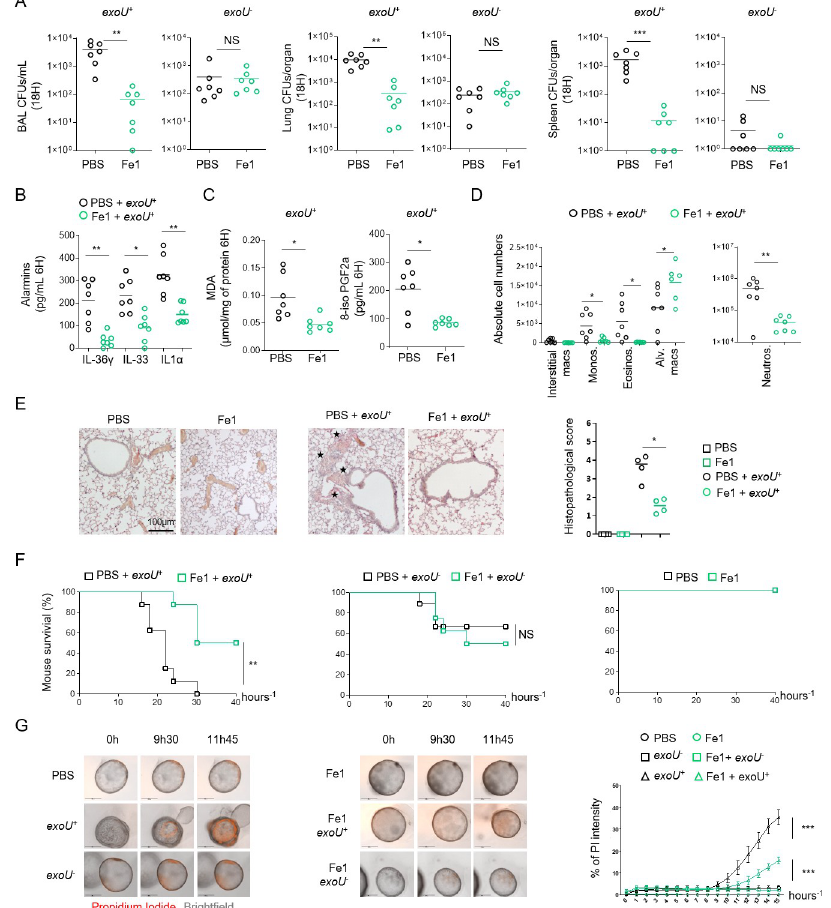
Fig 4. Ferrostatin-1 protects mice against ExoU-induced lung pathology. (A) Bronchoalveolar (BAL), lung and spleen bacterial loads from WT mice (n = 7/group) 18 hours after intranasal infection with 5.10 5 CFUs of P . aeruginosa PP34 or its isogenic mutant PP34 exoU- . When specified, mice were intraperitoneally pretreated with ferrostatin-1 (6mg. k -1 or PBS) 4 hours before intranasal infection. Graphs represent one experiment (7 mice/group) out of three independent in vivo experiments. �� p � 0.01, Mann-Whitney analysis test. NS: Not significant. (B, C) Alarmin and lipid peroxide products levels in bronchoalveolar fluids (BALFs) from WT mice (n = 7 mice/group) 6 hours after intranasal infection with 5.10 5 CFUs of P . aeruginosa PP34 or its isogenic mutant PP34 exoU- . When specified, mice were intraperitoneally pretreated with ferrostatin-1 (6mg.k -1 or PBS) 4 hours before intranasal infection. Graphs represent one experiment (7 mice/group) out of three independent in vivo experiments; � p � 0.05; �� p � 0.01, Mann- Whitney analysis test. (D) Immune cell (CD45+) populations in bronchoalveolar fluids (BALFs) from WT mice (n = 7 mice/group) 6 hours after intranasal infection with 5.10 5 CFUs of P . aeruginosa PP34 or its isogenic mutant PP34 exoU- . When specified, mice were intraperitoneally treated with ferrostatin-1 (6mg.k -1 or PBS) 4–6 hours before intranasal infection. Graphs represent one experiment (7 mice/group) out of three independent in vivo experiments; � p � 0.05; �� p � 0.01, Mann-Whitney analysis test. (E) Histological observation and scoring of bronchial and lung cellular infiltrations upon exoU -expressing P . aeruginosa intranasal infection. When specified, mice were intraperitoneally pretreated with ferrostatin-1 (6mg.k -1 or PBS) 4–6 hours before intranasal infection. Stars show the cellular infiltrates. � p � 0.05; Mann-Whitney analysis test. (F) Mice survival (n = 7 mice/group) 40 hours after intranasal infection with 5.10 5 CFUs of P . aeruginosa PP34 or its isogenic mutant PP34 exoU- . Mice were intraperitoneally pretreated with ferrostatin-1 (6mg.k -1 or PBS) 4 hours before intranasal infection. Graphs represent one experiment (7 mice/group) out of three independent in vivo experiments; �� p � 0.01, Log-rank Cox-Mantel test was used for survival comparisons. (G, H) Time-lapse microscopy and the associated quantifications of the measure of plasma membrane permeabilization using propidium iodide incorporation in human primary bronchial organoids infected (microinjection) with P . aeruginosa expressing exoU + or its isogenic mutant ( exoU - ) in presence or absence of ferrostatin-1 (40 μ M) for 15 hours. Data are plotted as means+/- SEM. ��� p � 0.001, T-test with Bonferroni correction. Data information: Data shown as means ( Graphs A-E ) and are representative of one experiment performed three times; � p � 0.05; �� p � 0.01, Mann-Whitney analysis test ( A-E) and log-rank Cox-Mantel test for survival comparisons ( F